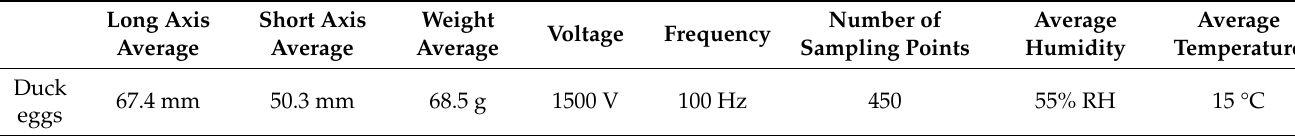
Table 7. Physical and experimental parameters of tested duck eggs.